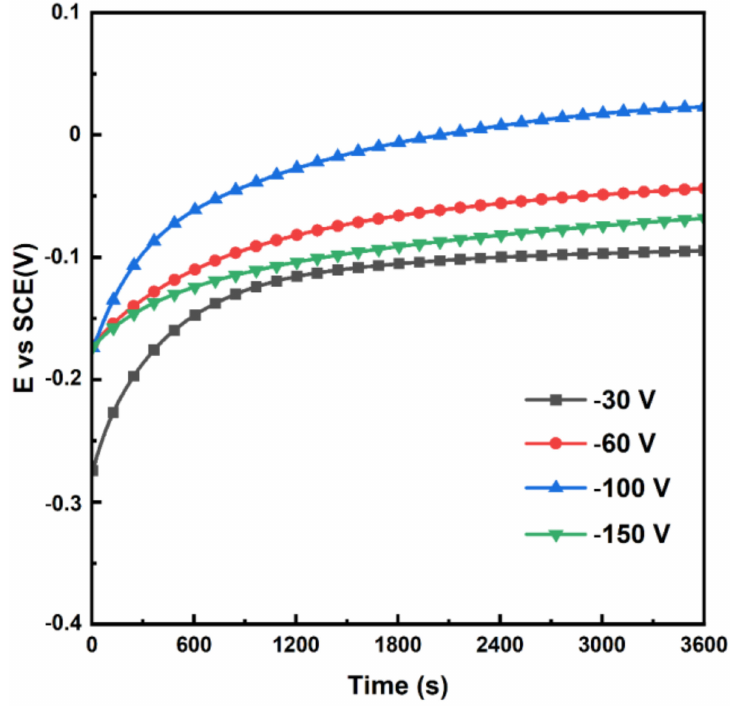
Figure 12. Open circuit potential of coatings deposited at various V s .